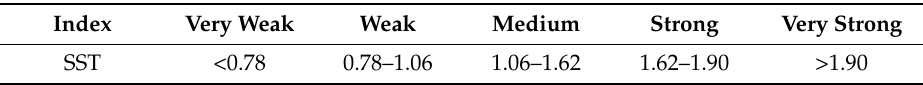
Table 1. Intensity indicators of El Niño and La Niña [51].